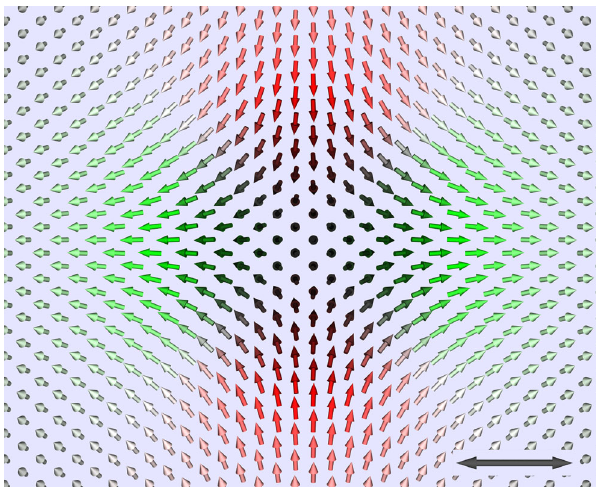
Fig. 4 Single stable antiskyrmion in 2Fe/W(110) at zero Zeeman fi eld. Each arrow represents the direction of the magnetic moment of one single atom. The color code is as in Fig. 1. For better visibility, only one-quarter of the Fe surface layer and no subsurface layer atoms are shown. The scale bar represents 3 nm. The antiskyrmions resulted from a simulation including interaction pairs of 8 (9) shells of neighbors for the intralayer (interlayer) coupling equivalent to a total of 26 (26)